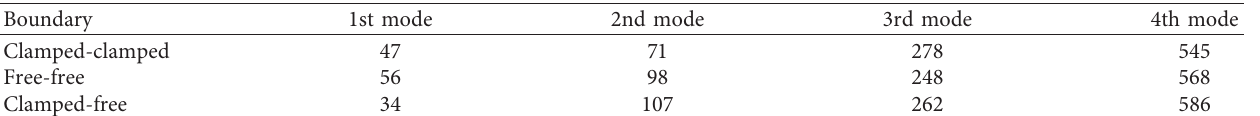
Table 3: Natural frequencies (Hz) with clamped-clamped and free-free boundaries for the composite model. Boundary